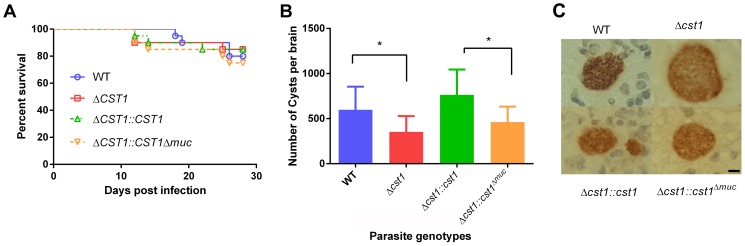
Brain cyst burden and survival rate of infected mice at 4 weeks post infection.(A) Survival curve of the mice challenged with the WT and mutant parasites (n = 20). (B) Brain cyst count of C57/BL6 mice infected with either WT, Δcst1, Δcst1:cst1 or Δcst1:cst1
Δmuc parasites sacrificed at 4 weeks post infection. The bars represent mean and standard deviation (n = 12). *p<0.05 (Mann-Whitney U test). (C) Immunohistochemistry of brain sections from infected mice probed with anti-GFP antibody demonstrates the formation of brain cysts in vivo. Pru parasites are stably transfected with LDH2-GFP enabling identification of bradyzoites within cysts. Bar, 10 µm.